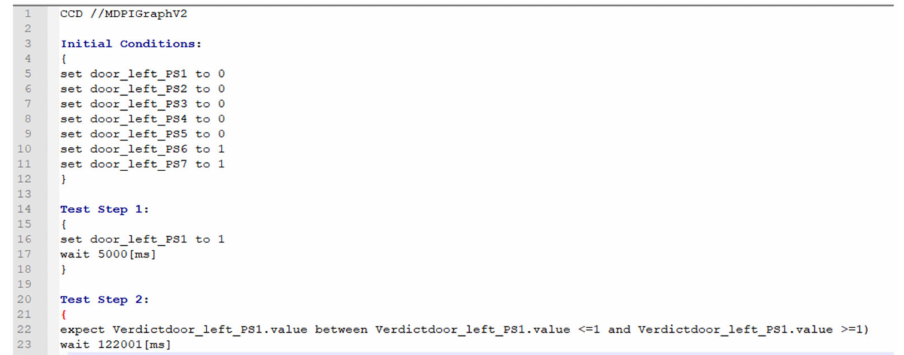
Figure 14. Fictive test case of a cabin